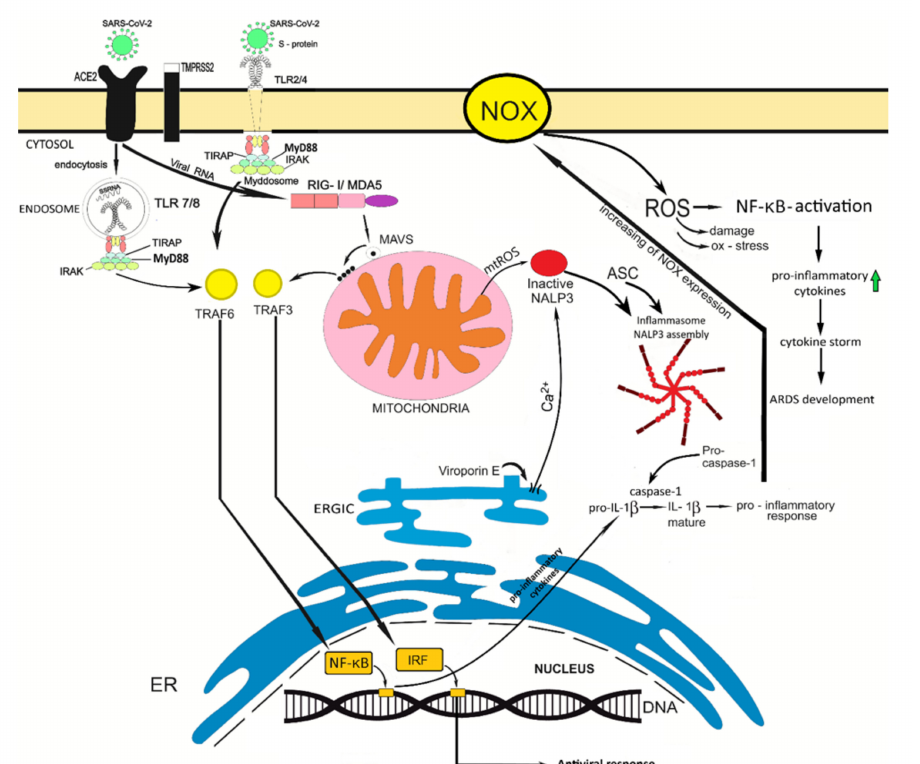
Figure 1. Possible ways of oxidative stress involvement in the COVID-19 disease. SARS-CoV-2 binds with ACE2 receptor; as a result, this virus enters into the host cells by endocytosis. The different virus components are recognized by PRR. For example, S-protein is distinguished by TLR2/4; ssRNA of coronavirus is distinguished by TLR7/8. Besides, RIG-I/MDA5 could identify dsRNA, a replication intermediate for RNA viruses. When sensing of dsRNA is performed, it leads to the cooperation with MAVS and further oligomerization process that attracts the adaptor proteins with subsequent activation of NF- κ B and IRF factors. Also, viroporin E is capable of changing the ion flows of Ca 2+ and K + which drive to NALP3 activation. TLRs sensing provides the recruitment of adaptor proteins which can form the myddosome complex for NF- κ B activation. NF- κ B signaling is linked by expression of interleukin precursors. The activation effects on NALP3 inflammasome are necessary to realize the olizomerization process and ASC recruitment. Eventually, the formed inflammasome converts pro-caspase-1 to active caspase-1 in order to execute the processing of pro-interleukins. Stimulation of NF- κ B signaling is associated with increasing of NOX expression, succeeded by ROS production. ROS can serve as signaling molecules that induce NF- κ B signaling as well. Thus, the excessive ROS production mediates the hyper-inflammation and development of cytokine storm that impact both the possibility of ARDS development and severity of ARDS